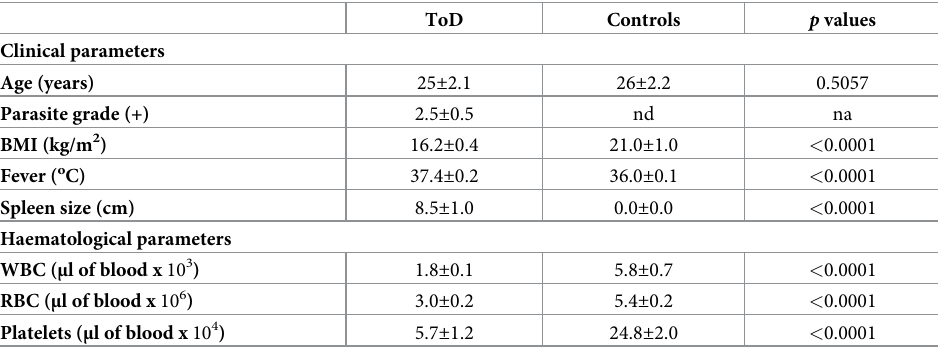
Table 1. Clinical and haematological parameters.